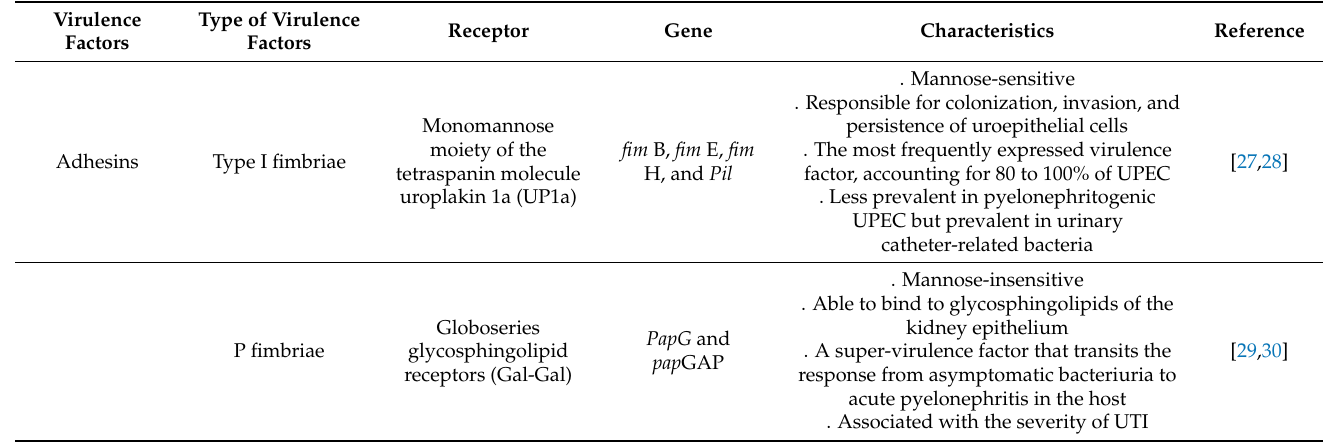
Table 2. Various adhesive fimbriae, toxins, and autotransporters contributing to virulence in